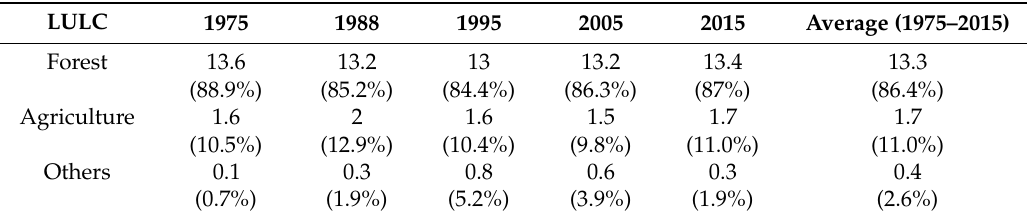
Table 5. LULC in the headwater Bagmati catchment between 1975 and 2015 (areas shown in km 2 ).